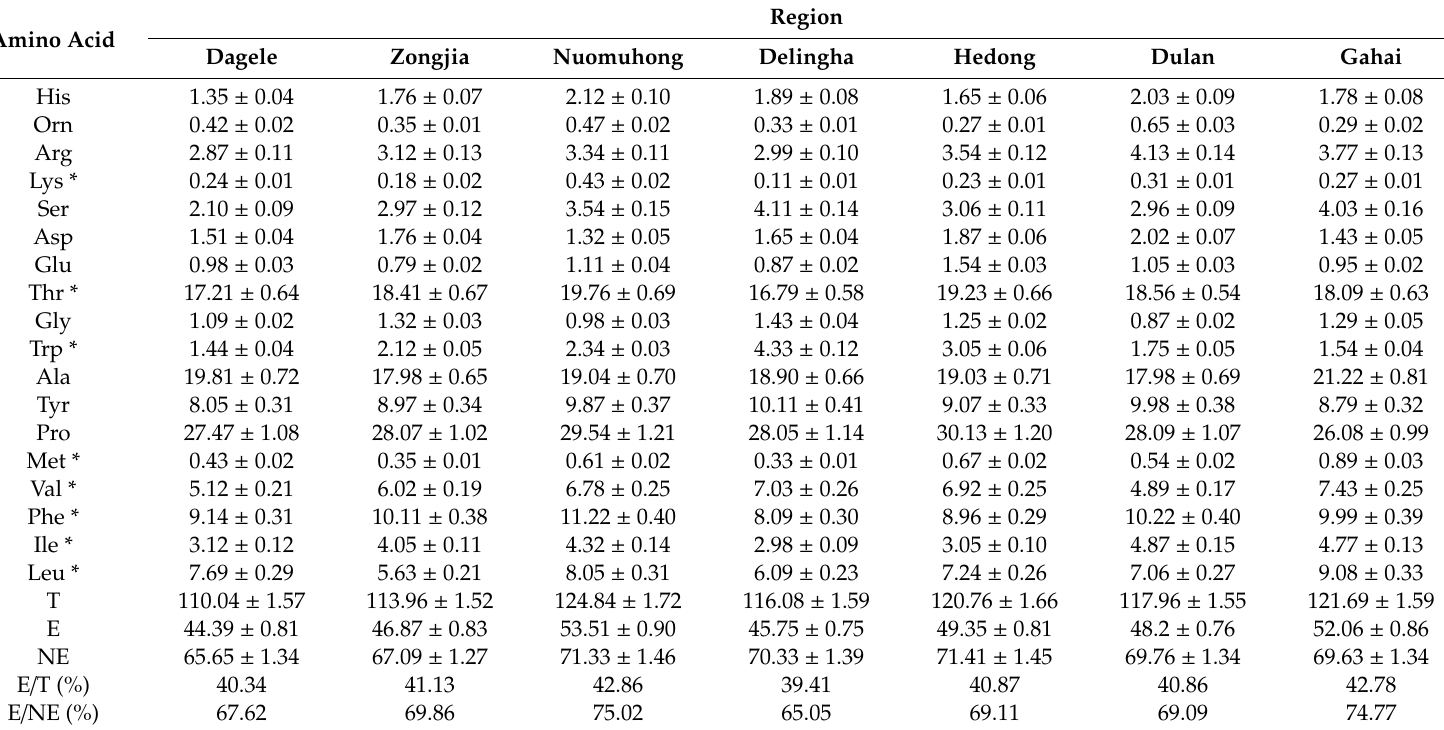
Table 2. The measured contents of amino acids in peel and pulp of Nitraria tangutorum Bobr. (mg / g). Amino